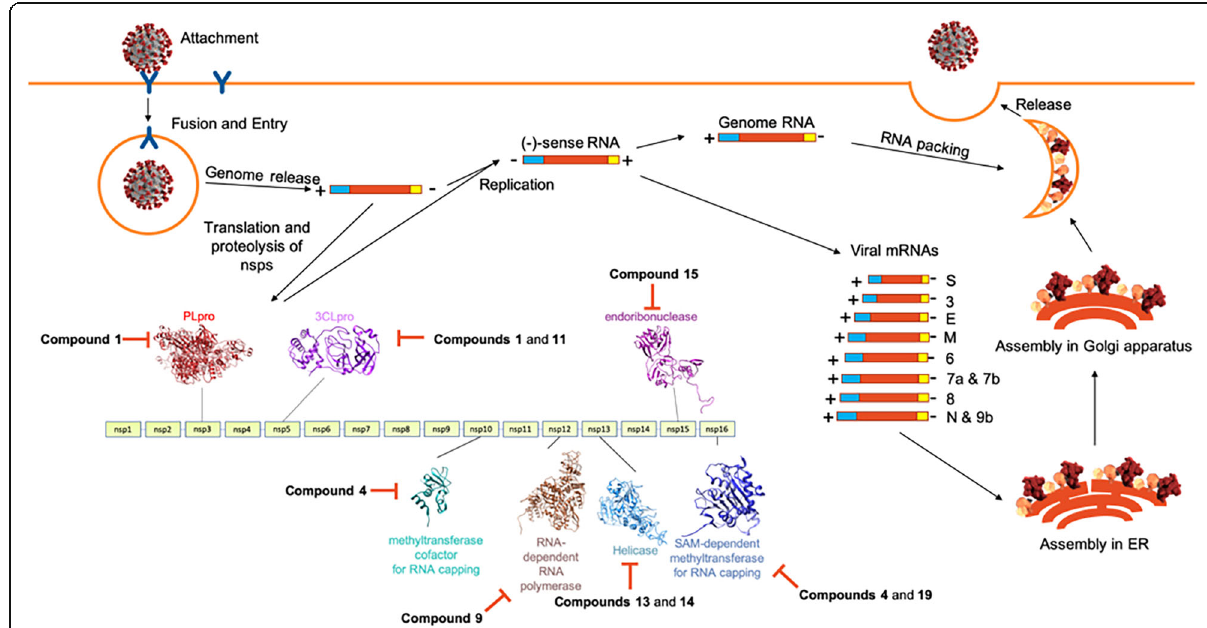
Fig. 7 The SARS-CoV-2 life cycle highlighting the role of nsps in replication and transcription and the potential inhibited target SARS-CoV-2 nsps of repurposed anti-HIV RT phytochemicals. SARS-CoV-2 virion image credit: CDC/ Alissa Eckert (MSMI) and Dan Higgins